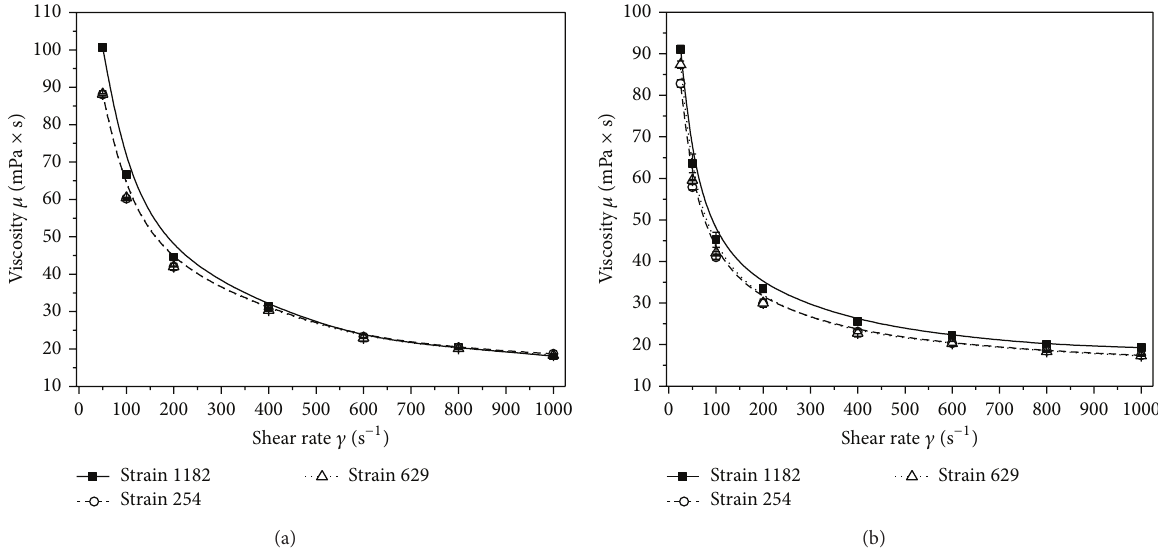
Figure 5: Apparent viscosities of the xanthan gums (0.5% w/v) obtained from SSAE (a) and from sucrose (b) at different shear rates 𝛾 (25 to 1000 s −1 ). Temperature is 25 ∘